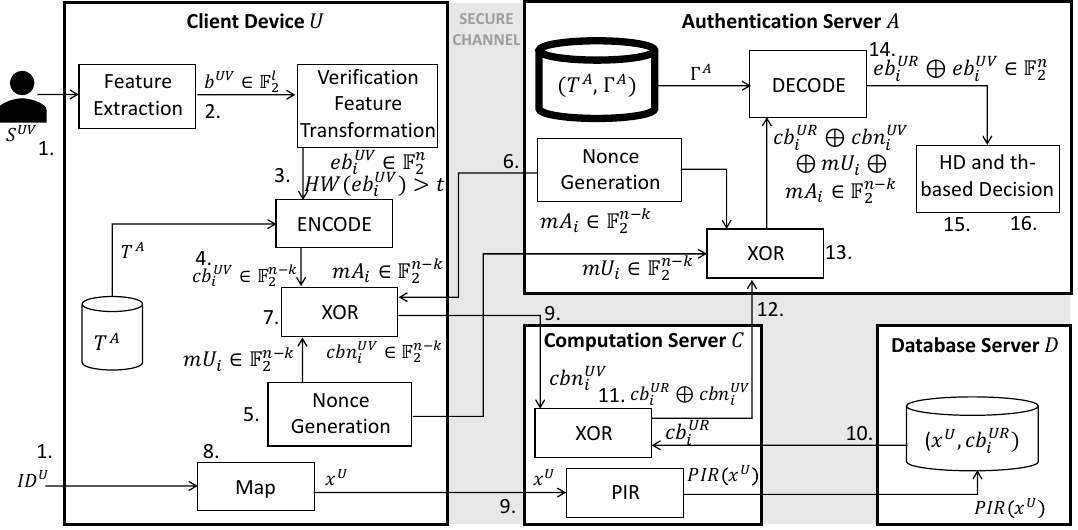
Figure 5. Verification phase of the distributed authentication protocol based on the Classic McEliece protection proposed.